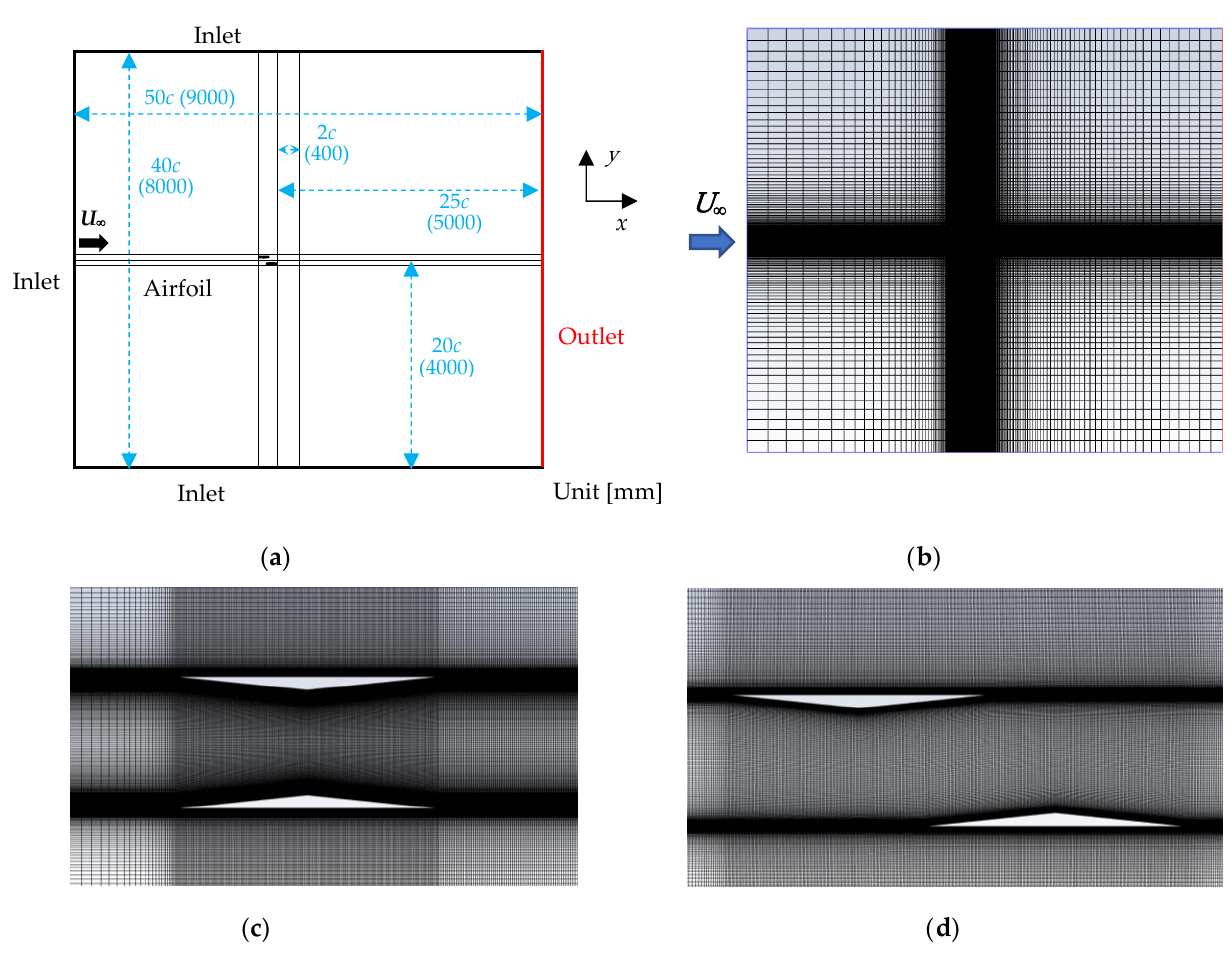
Figure 4. Meshes used for numerical calculations: ( a ) computational domain; ( b ) overview of grid; ( c ) grid distribution around the baseline model; ( d ) grid distribution around the 0.75 c stagger model.